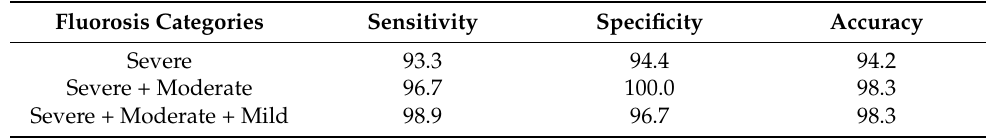
Table 2. Linear discriminant analysis (LDA). Sensitivity, specificity, and accuracy of the LDA model comparing dental fluorosis